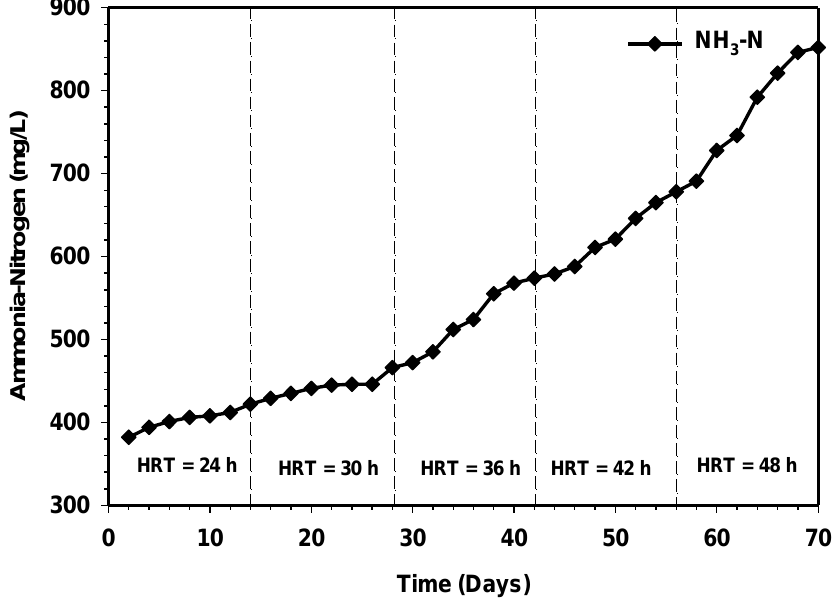
Figure 10. Variation of ammonia nitrogen relative to increasing contact time.